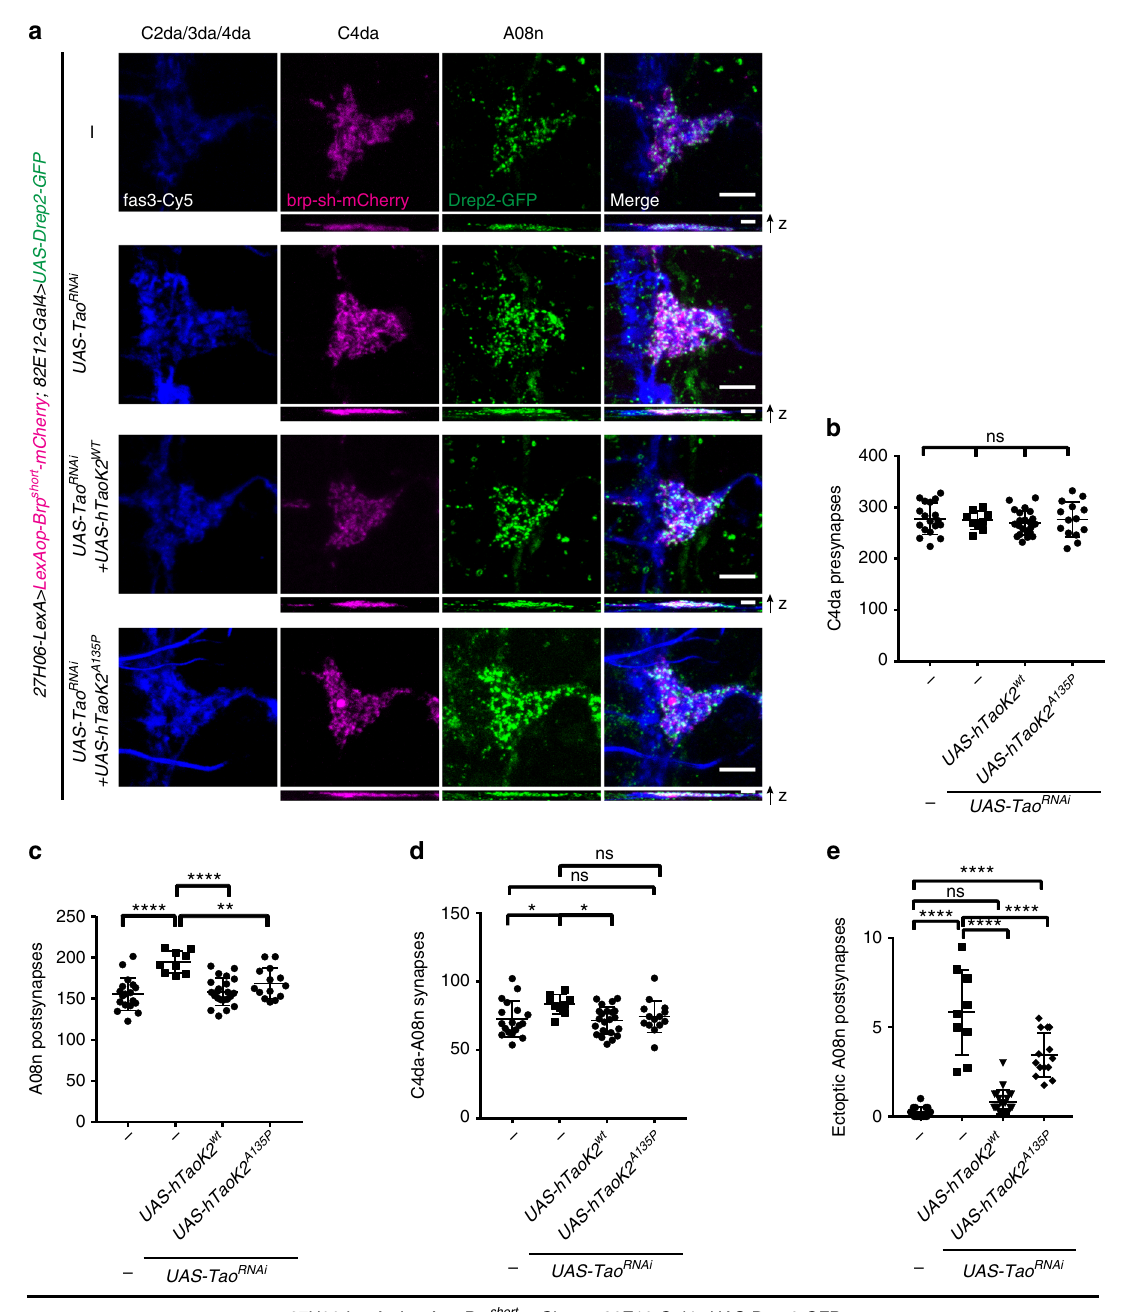
Fig. 5 Conserved Tao kinase activity regulates growth and connectivity. a Confocal images of larval VNC hemisegments (96 h AEL) in control or with Tao RNAi expression in A08n neurons, without or with co-expression of hTaoK2 wt or hTaoK2 A135P . Images show anti-Fas3 immunostaining labeling C2da, C3da, and C4da sensory axons (blue), with synaptic marker expression labeling C4da presynapses (magenta), and A08n postsynapses (green). Scale bar = 5 µ m. XZ projections of each channel are shown below. Scale bar = 2 µ m. b – e Quantitative analysis of synaptic pro fi les in control or with Tao RNAi expression in A08n neurons, without or with co-expression of hTaoK2 wt or hTaoK2 A135P for b C4da neuron presynapses, c A08n